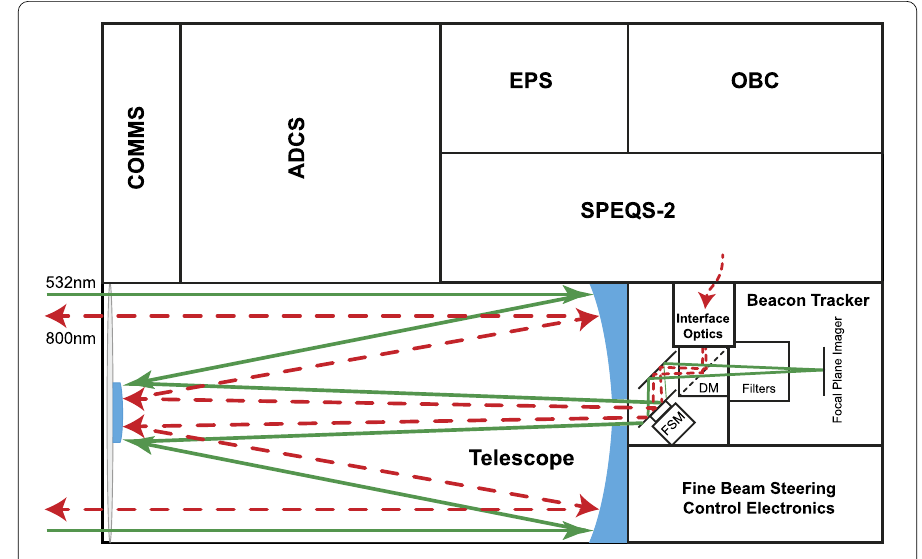
Figure 3 CQuCoM CubeSat Layout. One half of the structure is devoted to the transmission optics which includes a telescope, beacon tracker, beam steering, and optical interface with the quantum source. The platform systems (COMMS, ADCS, EPS, and OBC) are based upon the PICASSO 3U CubeSat developed by Clyde Space and VTT Finland for the Belgian Institute of Space Aeronomy and ESA. Body mounted solar panels would provide power to the EPS for storage and distribution. Communications would be handled by UHF, S-band, and X-band radio systems. The ADCS consists of Earth, Sun and star trackers, magnetorquers, and 3-axis momentum wheels. The OBC handles systems operations. Processing of data is performed in the mission computer as part of the entangled photon source (SPEQS-2)